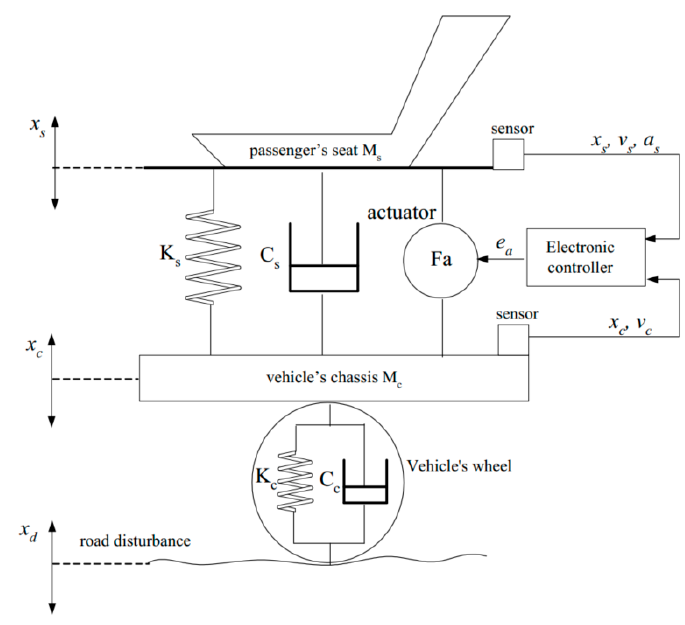
Figure 20. The schematic diagram of the model used in SystemC-A [67].